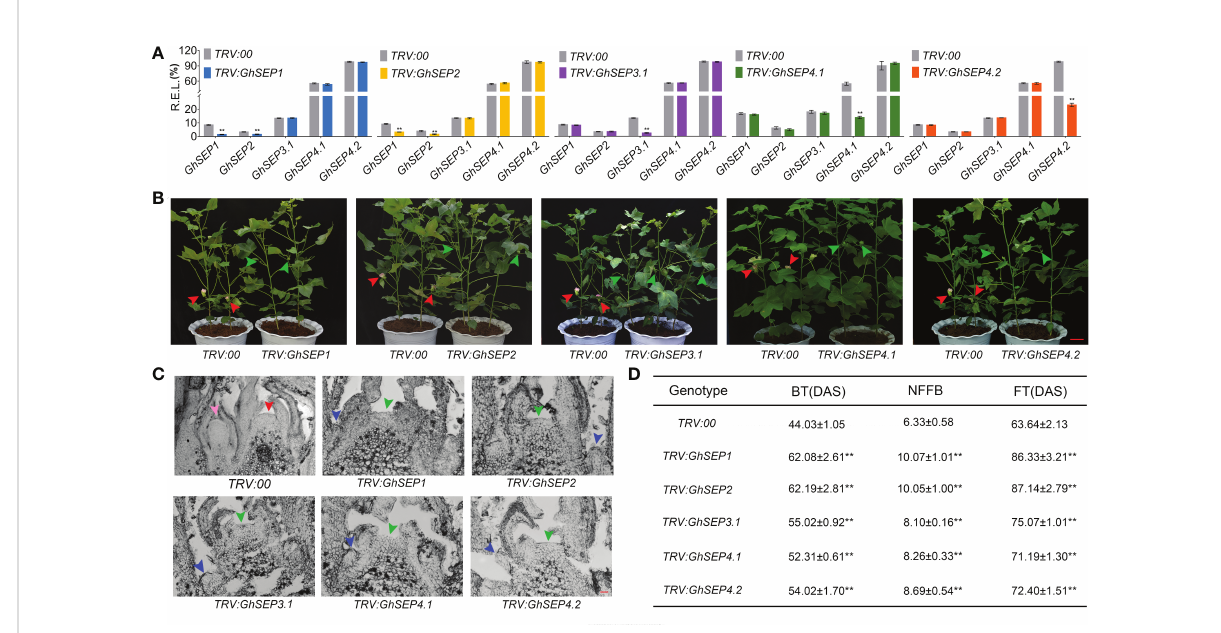
FIGURE 4 Phenotypes of virus-induced gene-silencing plants of TRV : GhSEP s. (A) Relative expression of each GhSEP gene in cotton silencing lines. Asterisks indicate signi fi cant differences according to Student ’ s t -test at p ≤ 0.01. Error bars denote SD. (B) Silencing of GhSEP s delayed the fl owering of cotton. The green and red arrows represented the buds and fl owers, respectively. The same control plants were used in the checking of the silencing plants of GhSEP1 , GhSEP3.1 , and GhSEP4.2 for taking photos. Scale bar stands for 10 cm. (C) Section of the shoot apexes at four TLSs of control and silencing plants. The in fl orescence meristem and fl oral meristem are labeled by red and pink arrows. Blue and green arrows point the young leaf and SAM. Scale bar stands for 1 mm. (D) Statistics of traits related to the early maturity of cotton silencing and control plants. Data were shown as the average ± SD. Asterisks indicate signi fi cant differences according to Student ’ s t -test at p ≤ 0.01. BT, budding time; NFFB, node of the fi rst fruit branch; FT, fl owering timing; DAS, days after